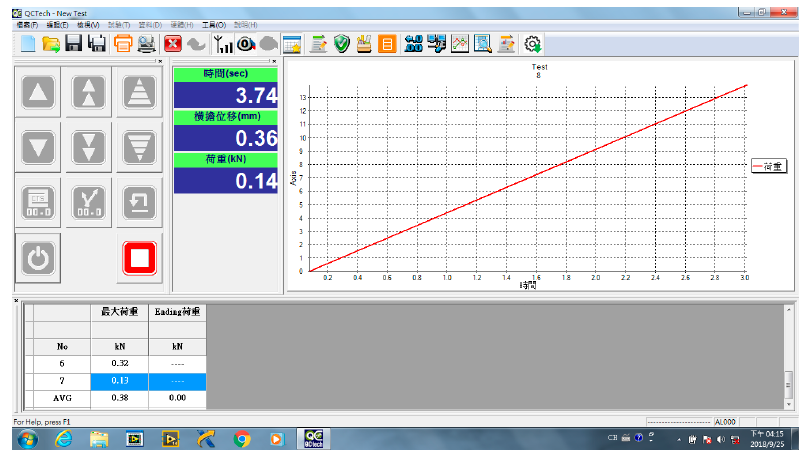
Figure 7. The relationship of loading and time in MTS.